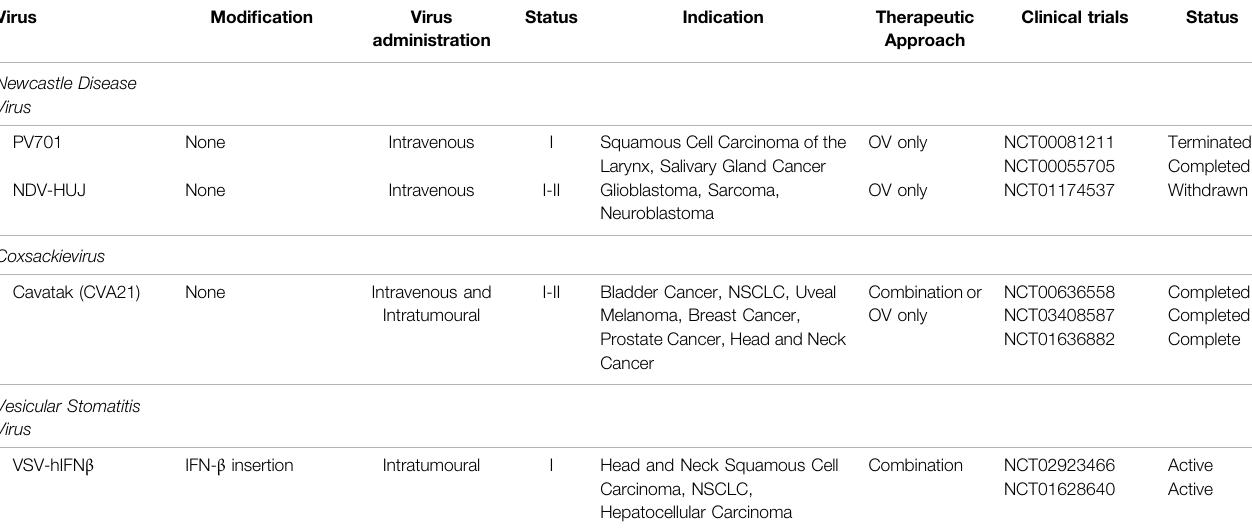
TABLE 2 | ( Continued ) Oncolytic virus anti-tumor clinical